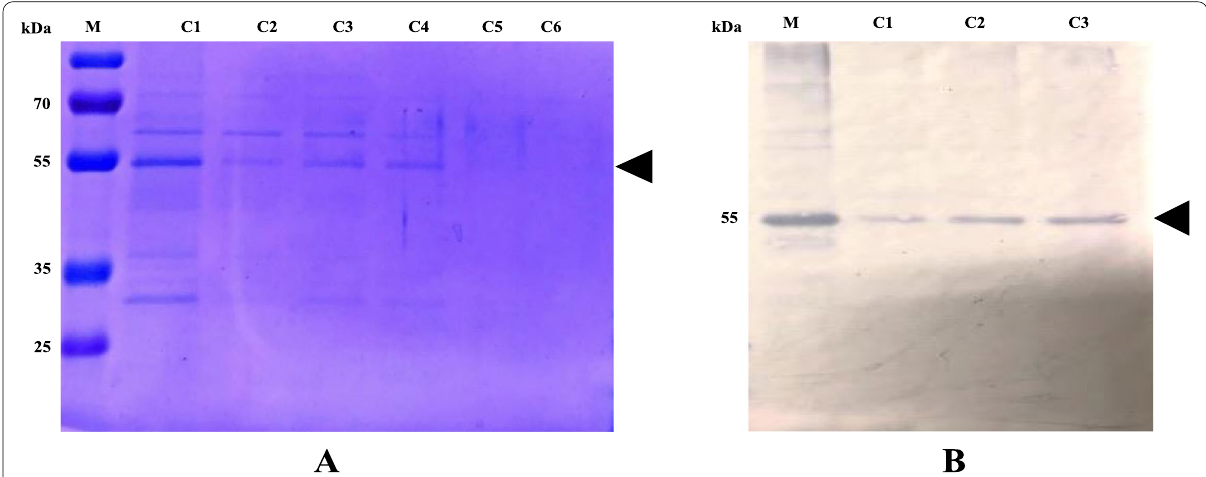
Fig. 7 Proteolytic removal analysis of poly histidine-tagged SUMO fusion protein from L1-HPV52 A SDS-PAGE, B western blot with anti-L152-AP. Lane C1-C4, fraction of cleaved products; lane M molecular weight size marker (kDa)